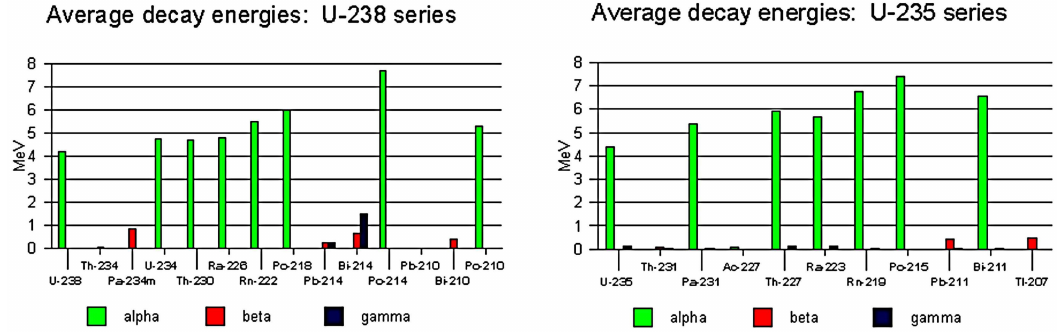
Figure 2. Average decay energies of U-238 and U-235 series. Source: WISE Uranium Project